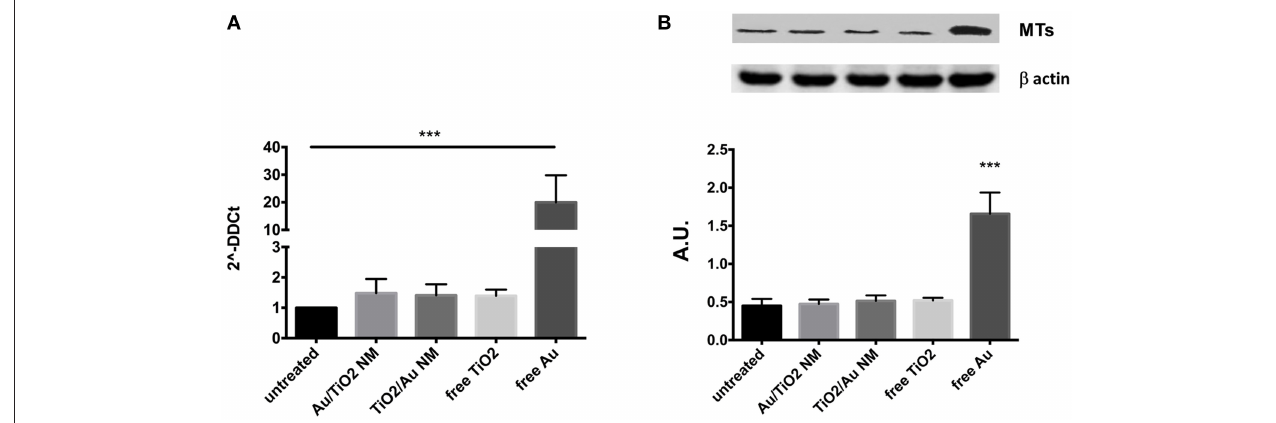
FIGURE 4 | (A) Western blotting analysis for evaluation the effects of exposure to free nanoparticles and nanomaterials. The MTs level in untreated samples and in larvae exposed to nanomaterials (Time 0/Time12) and free TiO 2 and Au nanoparticles was evaluated. The data are expressed as mean ± SEM. Statistical analysis was carried out by ANOVA test. A p -value of less than 0.05 ( p < 0.05) was accepted as statistically significant between experimental and control groups. (B) mRNA gene expression of mt in zebrafish after exposure to free nanoparticles and nanomaterials. The mt mRNA expression was increased only in free Au treatment. Bars represent the mean ± SEM of three independent experiments. *** P < 0.0001 vs. untreated sample. (Calculated value of 2 ∧ − 11 Ct in untreated sample was